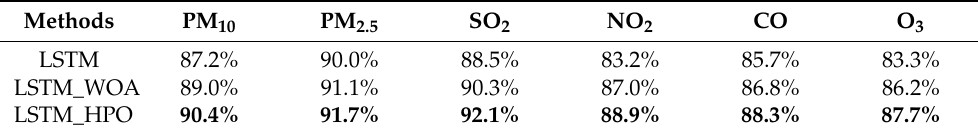
Table 14. The accuracies of the LSTM_HPO compared with LSTM and LSTM_WOA in dataset 1. Methods